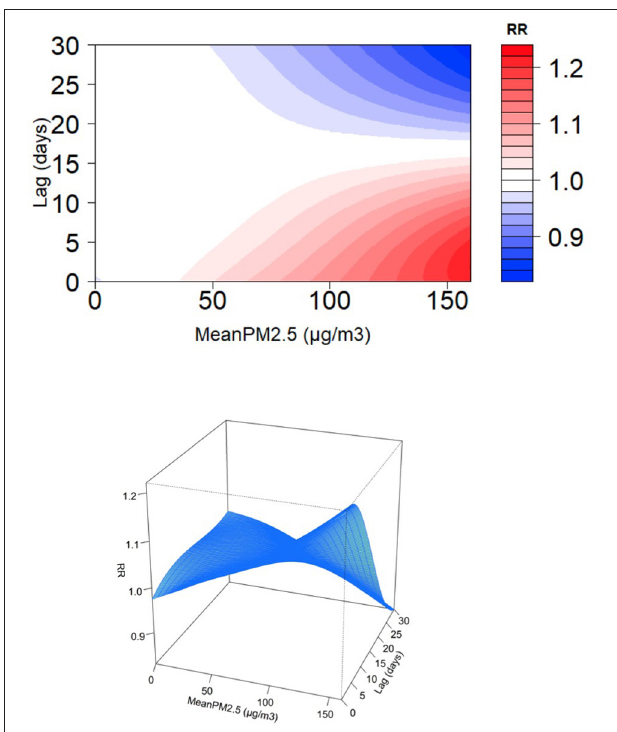
FIGURE 4 | Relative risk for daily pediatric respiratory outpatients with per unit increase of PM 2.5 at different cumulation lag